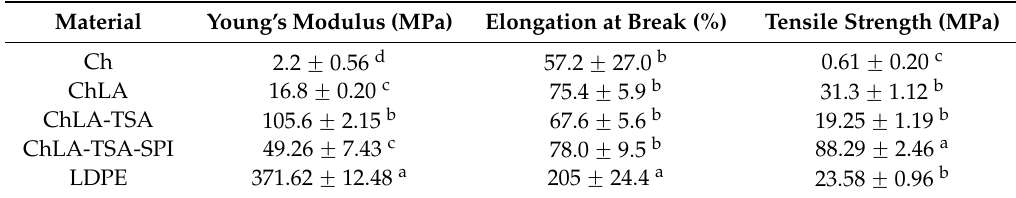
Table 2. Mechanical properties of the prepared